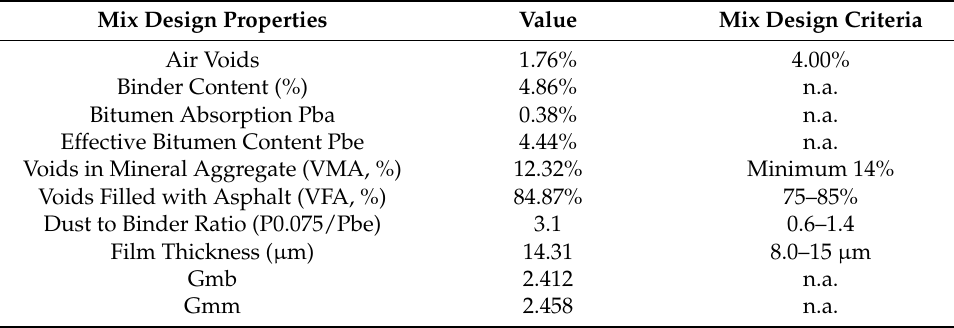
Table 1. Mix design properties of 4.86% bitumen content existing in RAP materials.